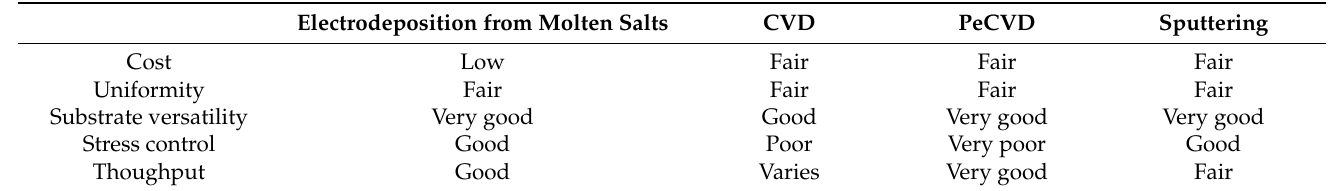
Table 3. Comparison among some methods used to grow SiC